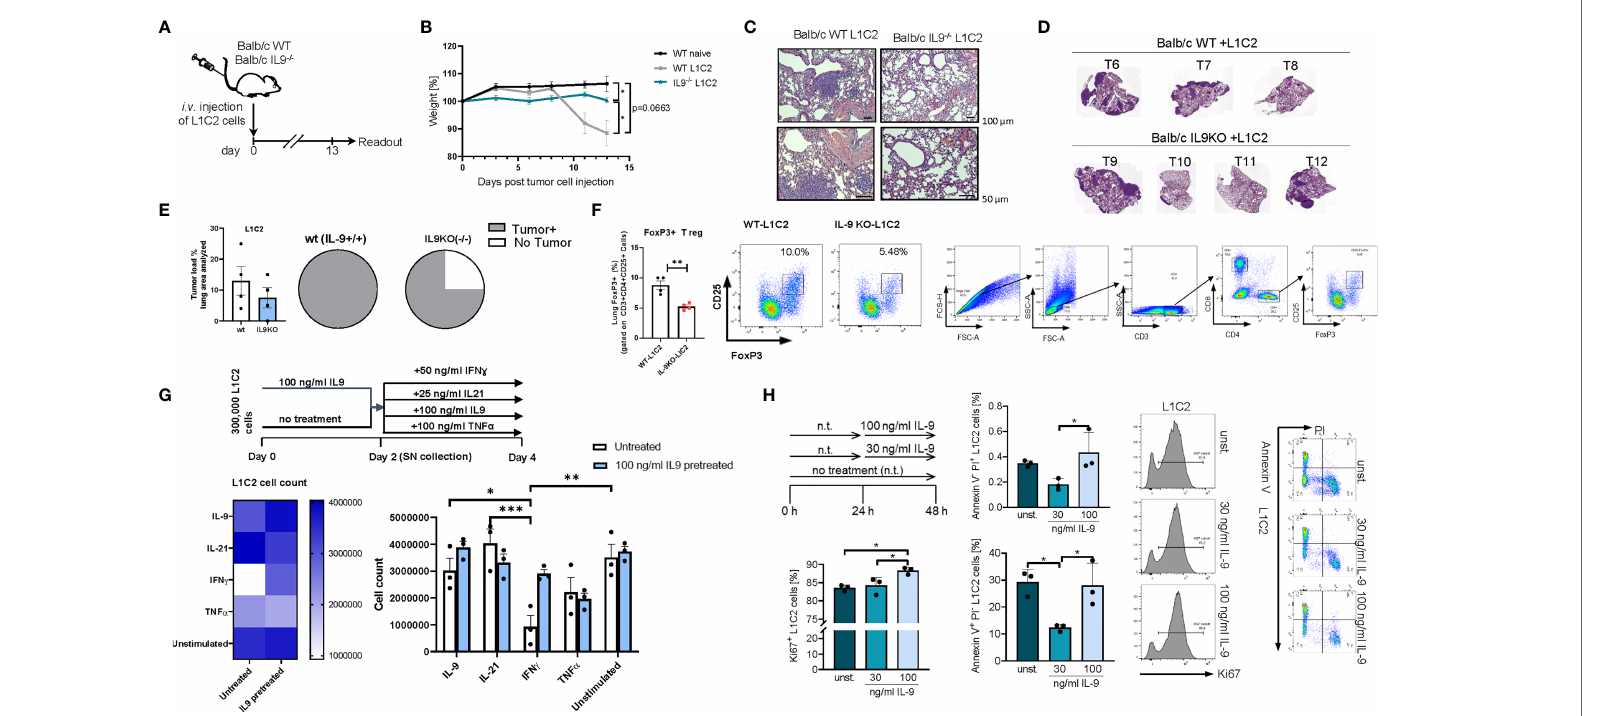
FIGURE 7 | Targeted deletion of IL-9 resulted in lung tumor rejection Balb/c syngenic mice. (A) Experimental design for the induction of lung tumor development in Balb/c wild-type (WT) and Balb/c IL9 -/- mice. Tumor growth was induced via intravenous (i.v.) injection of L1C2 lung carcinoma cells. The experiment ended on day 14. (B) Body weight changes of Balb/c IL9 -/- mice and Balb/c control littermates (injected i.v. with/out L1C2 cells) 0 to 14 days after tumor induction (n IL9-/- =4; n balb/c L1C2 = 3; n balb/c naive =2). (C) Representative H&E staining of the lung of WT and IL-9 -/- mice (top, scale bar=100 µm; bottom, scale bar=50 µm) and (D, E) additional mice were evaluated by a pathologist in a blind manner (n=4 per group). Circles represent mice per group tumor free (sectors in white) and mice with lung bearing tumor (sectors in grey). (F) FACS analysis of Foxp3+ CD25+ T regulatory cells in total lung cells of 4 wt and 4 IL9 ko mice after gating on CD3+CD4+ T cells. (G) Experimental design is similar to the A549 cell line culture whereby L1C2 were pre-cultured or not for 2 days of IL9 (100 ng/ml) and then further cultured for 2 days unstimulated or cultured with either IFN ɣ , or IL9, IL21 or TNF a , respectively. The data were statistically analyzed with two- way ANOVA, and showed with mean ± SEM. n=3 per group. *, P<0.05; **, P<0.01; ***, P<0.001; ****, P<0.0001. (H) Flow cytometry analysis of the percentage of Ki67 expressing L1C2 cells after stimulation with or without IL-9 for 24h and representative histograms (n-unst. = 3; n30 ng/ml=3; n100 ng/ml=3). Annexin V/PI fl ow cytometry analysis of L1C2 cells after stimulation with or without IL-9 for 24h and representative dot plots (n-unst. = 3; n30 ng/ml=3; n100 ng/ml=3). Bar charts indicate mean values ± SEM using student´s two-tailed t-test (b-g) or ordinary one-way ANOVA (i-j) (*p < 0.05, **p < 0.01, ***p <